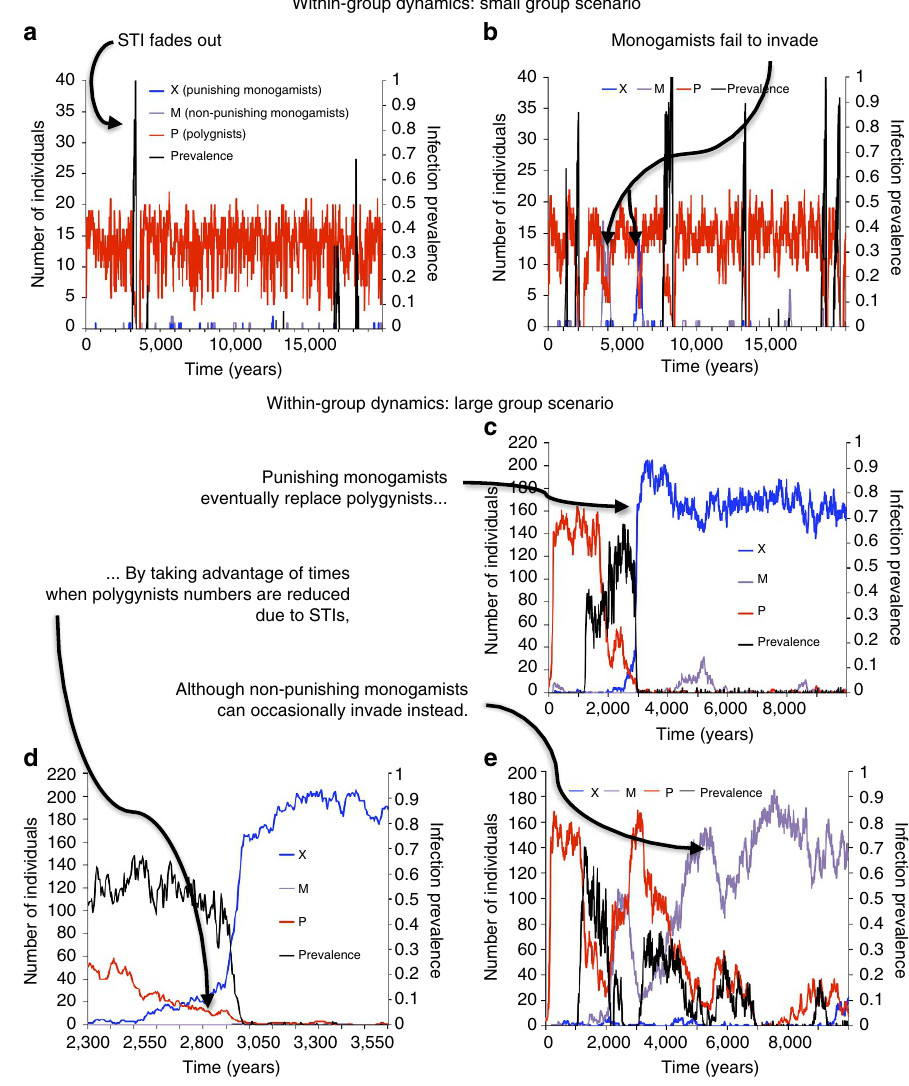
Figure 1 | STIs become endemic when groups become large and thereby enable punishing monogamists to take over most groups. Panels show the numbers of punishing monogamists X (blue), non-punishing monogamists M (purple), polygynists P (red) and infection prevalence (proportion infected; black) for the small group scenario in two different groups ( a , b ) as well as for the large group scenario in a group over both a long time window ( c ) and a shorter time window showing the transition period ( d ), as well as a different group exhibiting a less common outcome where monogamists dominate ( e ). Group carrying capacity is 30 individuals for the small group scenario ( a , b ) and 300 individuals for the large group scenario ( c – e